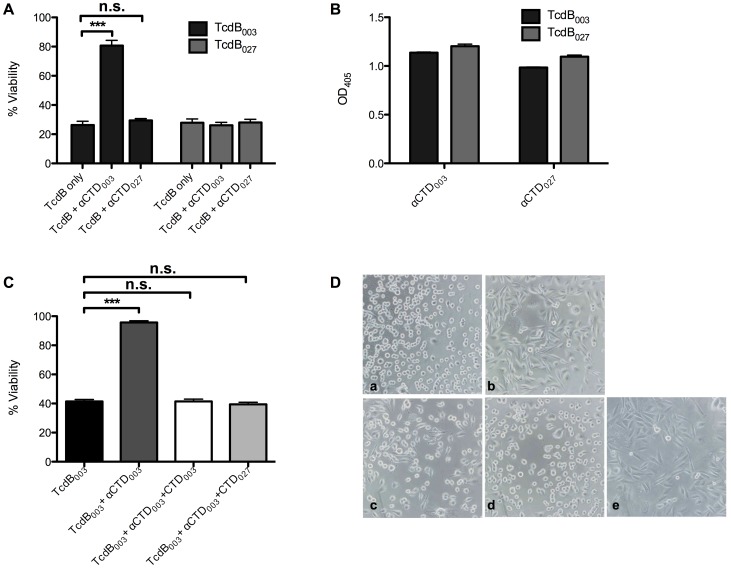
Neutralization of TcdB with αCTD antiserum.(A) Percent viability of CHO cells treated for 24 hrs with 37 pM of TcdB003 (black) or TcdB027 (gray) alone or after preincubation for 1 h with αCTD003 antiserum or αCTD027 antiserum. Cell viability was determined by WST-8 staining and the error bars represent the standard deviation from the mean of three biological replicates containing three technical replicates. *** p<0.001 (B) ELISA data showing the specificity of the αCTD antibodies to TcdB003 (black) and TcdB027 (gray) as measured by the optical density at 405 nm. The error bars represent the standard deviation from the mean of three samples. (C) Percent viability of CHO cells treated for 24 hrs with 37 pM TcdB003 alone (black) or combined with αCTD003 antiserum (dark gray), or with αCTD003 antiserum plus 3.7 nM of the CTD003 (white) or CTD027 (light gray) protein fragments. Cell viability was determined by WST-8 staining and the error bars represent the standard deviation of three biological replicates containing three technical replicates. *** p<0.001 (D) Representative phase contrast photographs of CHO cells after 6 h exposure to (a) 370 pM of TcdB003 alone or 370 pM TcdB003 with (b) 1∶100 CTD003 antiserum or 1∶100 CTD003 antiserum plus (c) excess CTD003 or (d) CTD027 (e) untreated control.